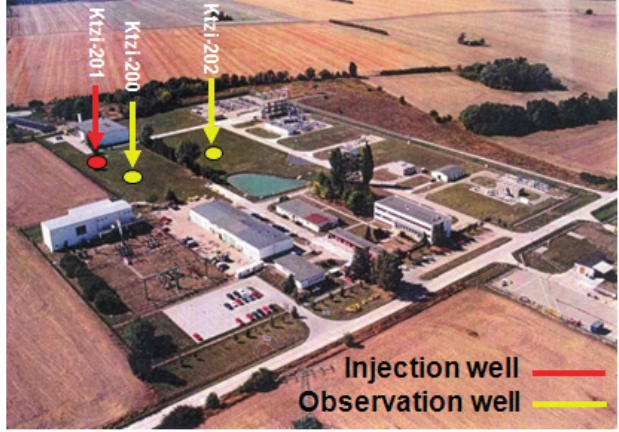
Figure 1. Location of boreholes at Ketzin industrial